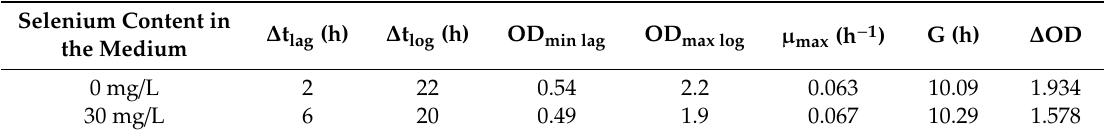
Figure 1. Effect of selenium on the growth of Candida utilis yeast cells. Table 1. Parameters characterizing the growth Candida utilis ATCC 9950 during culturing in the control YPD medium and experimental media enriched in selenium.